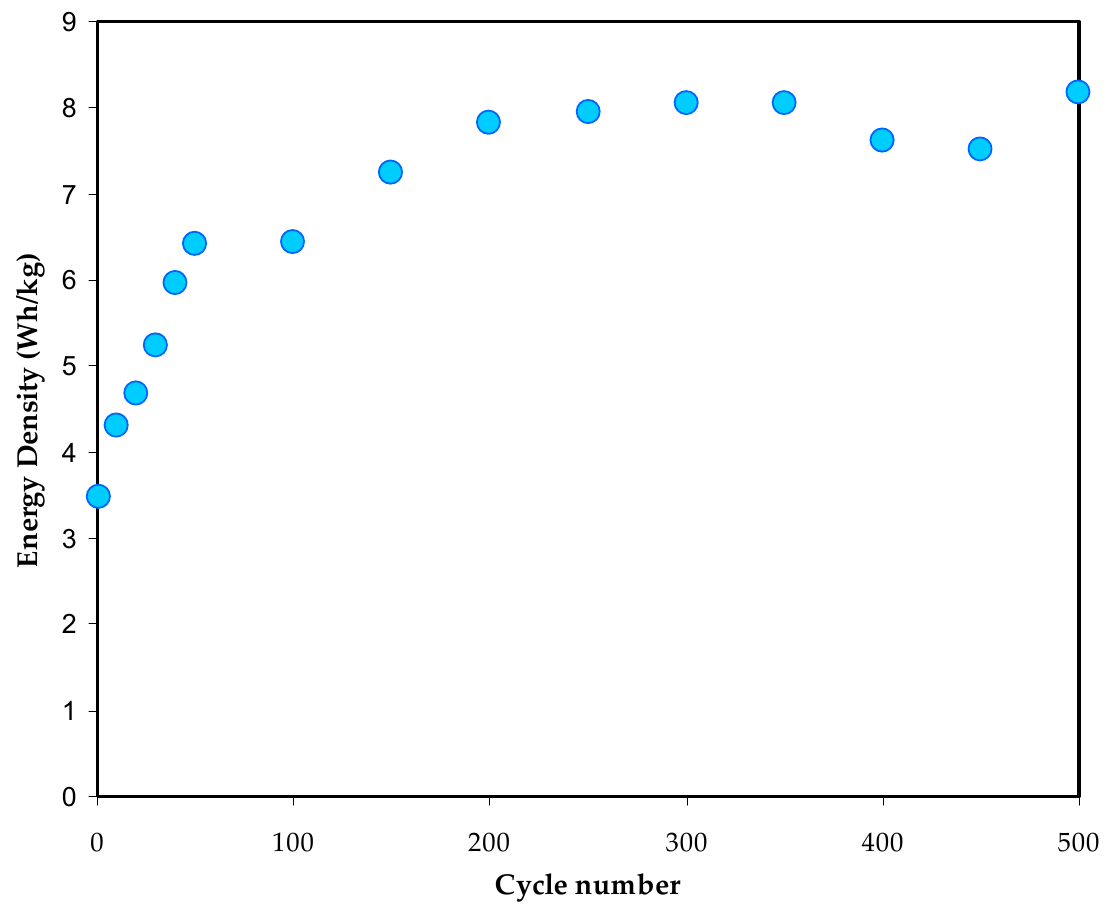
Figure 19. Energy density ( E ) trend of the fabricated EDLC over 500 cycles.